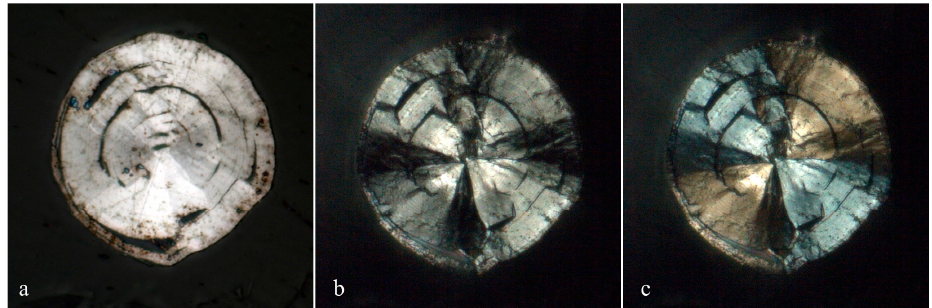
Figure 7. Reflected light microscope images of a polished axial section of a merelaniite whisker (0.09 mm diameter) (Nikon Optiphot-Pol petrographic microscope): ( a ) polarizer and analyzer both aligned horizontally; ( b ) crossed polarizers; and ( c ) slightly un-crossed polarizers. (A. E. Seaman Mineral Museum collection DM 31323, reference 3666cr2).